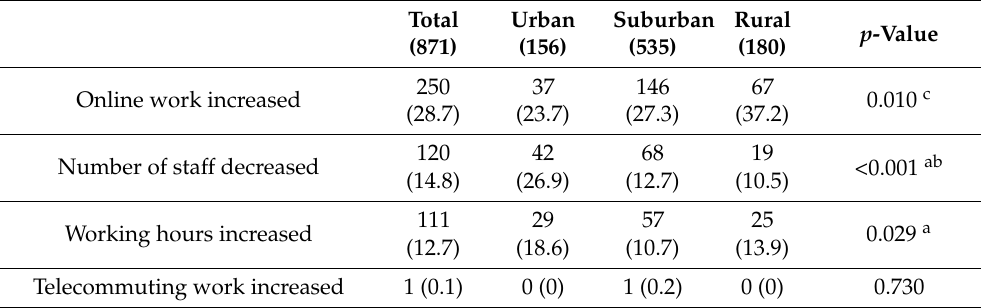
Table 3. Changes in work environment after the start of the pandemic (N, %) (Q7).